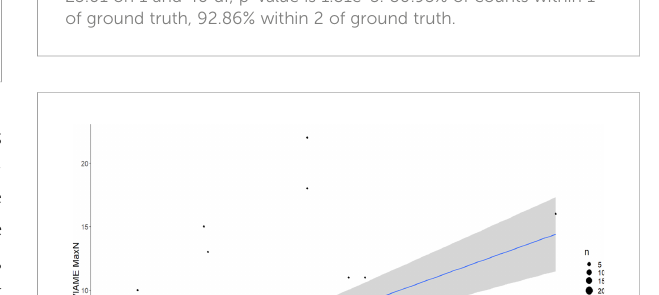
FIGURE 6 Comparison of automated counts at the top performing model (2.4s) and con fi dence threshold (0.7) for Red Snapper , Lutjanus campechanus (the species with the most observations across all stations of the survey). Total agreement sample size (n) at con fi dence of 0.7 was 207. Residual standard error is 1.451 on 205 df. Linear regression is VIAME MaxN = Validation Set MaxN *(0.7) + 1 with r2 of 0.9439. F-statistic is 3450 on 1 and 205 df, p = 2.2e-16. 79.22% of counts within 1, and 85.99% were within 2 of validation set counts.